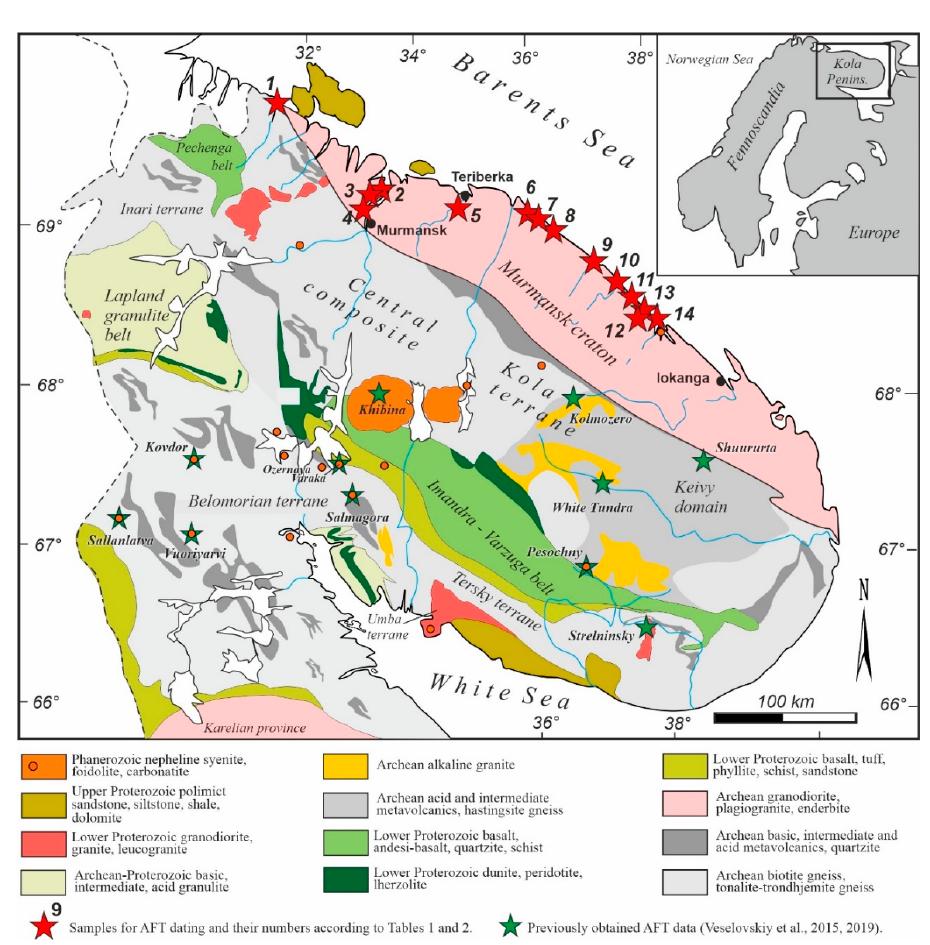
Figure 1. Schematic tectonic map of the Kola Peninsula showing sampling localities. AFT—apatite fission ‐ track.